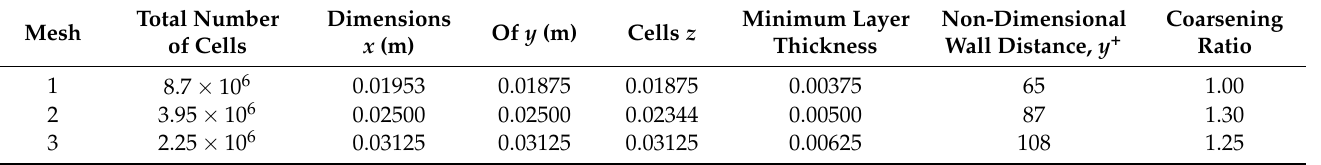
Table 2. Mesh resolutions used for the verification study for the model scale